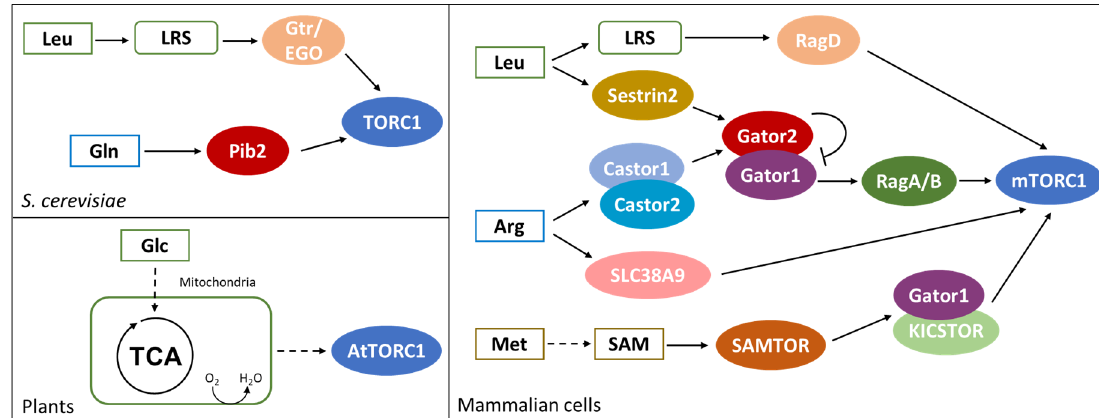
Figure 3. TOR modulation in yeast and in mammalian cells. Both in S. cerevisiae and in mammalian cells, leucine activates TOR through Leu-tRNA-synthase (green boxes). In addition, Gln in yeast (blue box), Arg and Met in mammalian cells (purple and orange boxes, respectively) were shown to activate TOR. Contrary to yeast and mammals, in plant cells TOR activity is controlled by glucose oxidation and mitochondrial metabolism. See text for details.